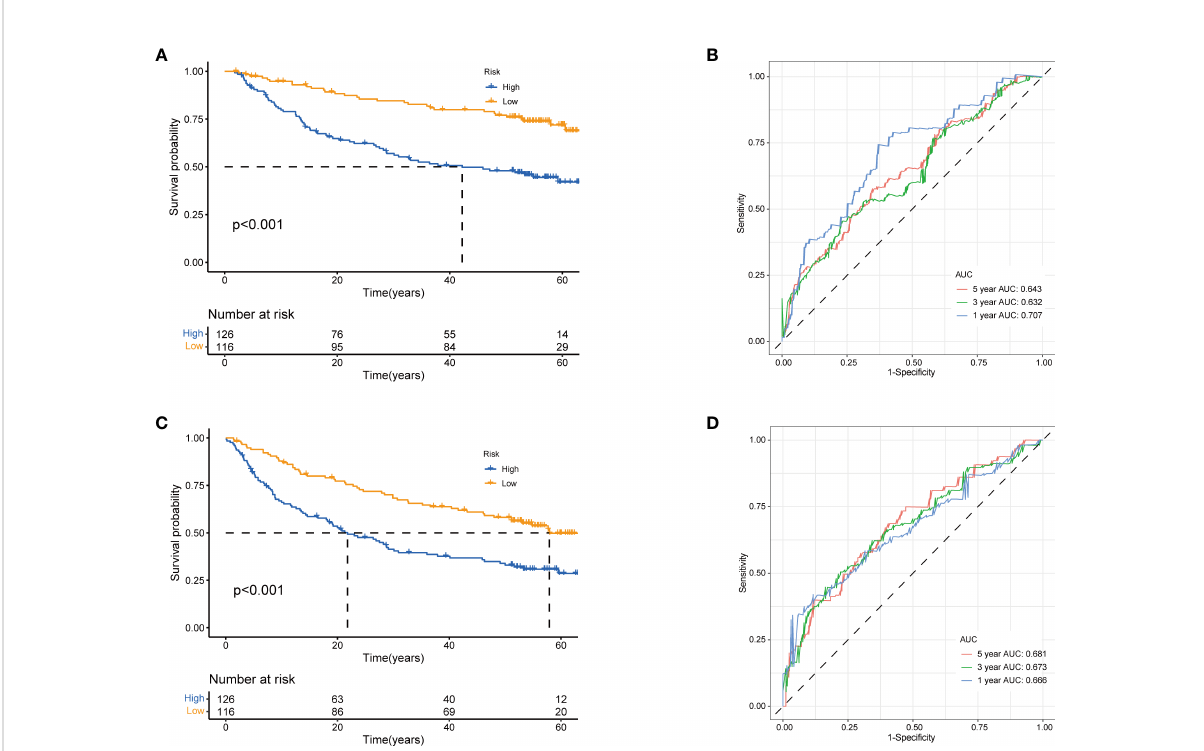
FIGURE 6 Validation of prognostic model based on TRGs. Kaplan-Meier survival curves of high- and low-risk groups in validation dataset GSE14520 (A) , OS. (C) , RFS (log-rank tests, p<.001). The receiver operating characteristic curve for predicting 1-year, 3-year, and 5-year OS (B) and RFS (D) of HCC patients in GSE14520. TRGs, tyrosine metabolism-related genes; HCC, hepatocellular carcinoma; RFS, relapse-free